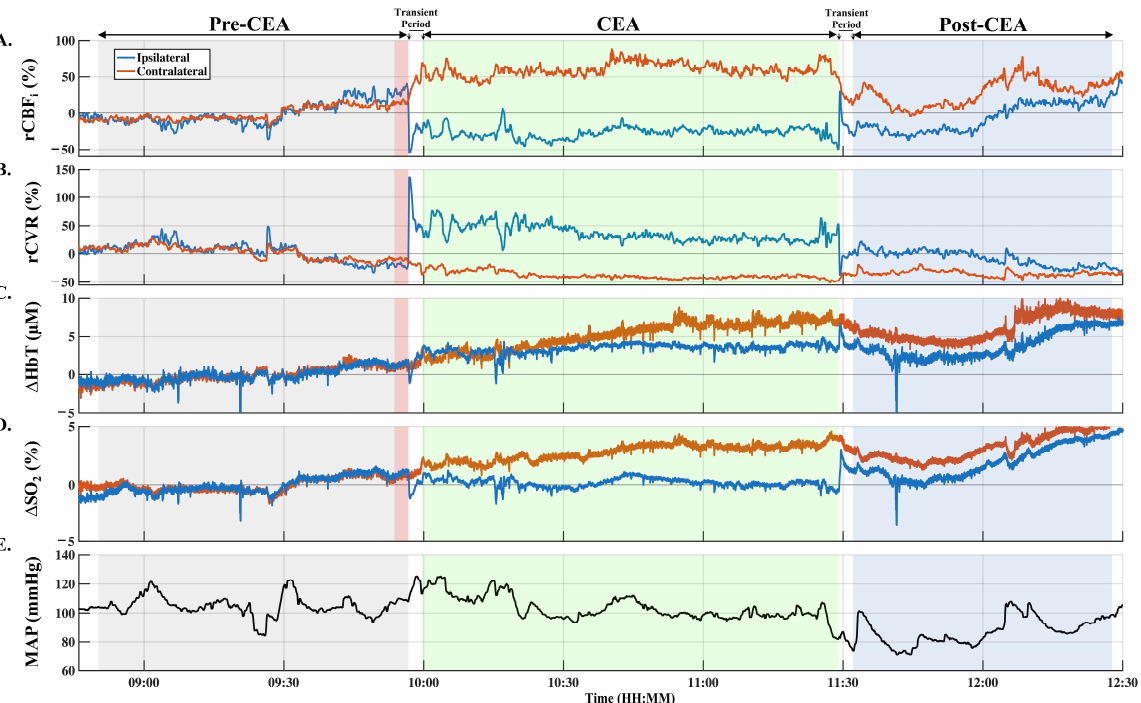
Figure 2. A typical measurement on a patient (#21, MCS group) during CEA. Ipsilateral and con- tralateral cerebral hemodynamic changes are shown in blue and orange, respectively, for rCBF i ( A ), rCVR ( B ), ∆ HbT ( C ), and ∆ SO 2 ( D ). MAP (( E ), black) was measured invasively via an arterial cannula in the arm. All data are normalized with respect to the pre-CEA phase (long baseline), represented in grey and red shaded areas, except MAP. A three-minute short baseline is represented in the red shaded area. CEA and post-CEA phases are represented in shaded light green and blue areas, respectively. CEA, carotid endarterectomy; rCBF i , relative cerebral blood flow index; rCVR, relative cerebrovascular resistance; ∆ SO 2 , changes in oxygen saturation; ∆ HbT, changes in total hemoglobin concentration; MAP, mean arterial